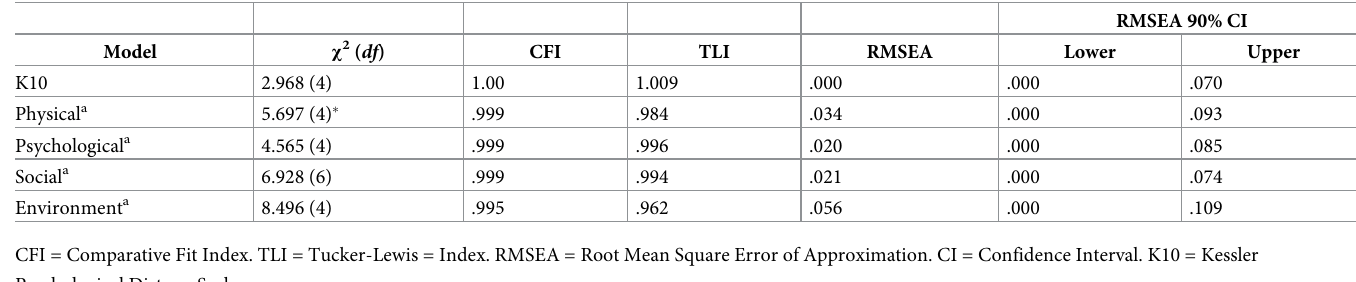
Table 4. Summary of fit statistics for path analysis